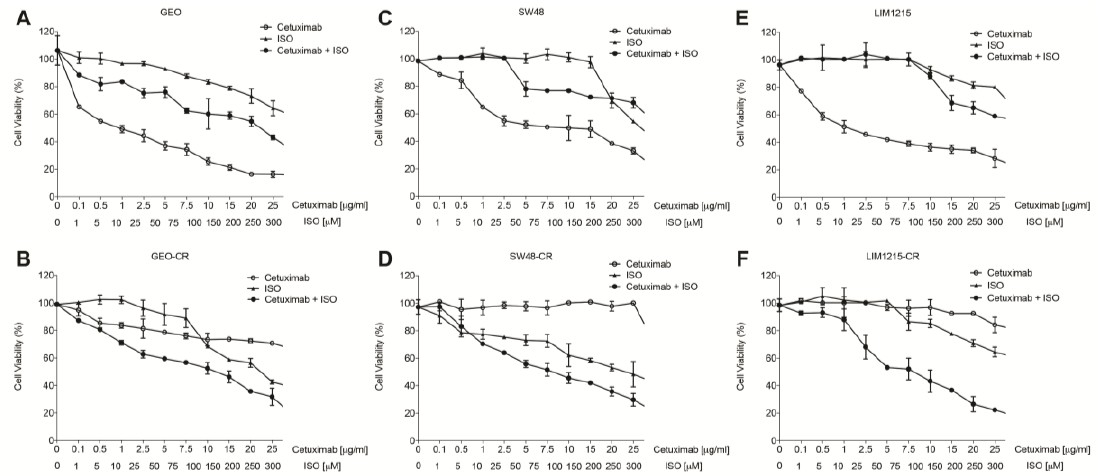
Figure 4. ( A ) MIF inhibition by the non-covalent inhibitor ISO-1 affects GEO ( A ) and GEO-CR ( B ), SW48 ( C ) and SW48-CR ( D ), LIM1215 ( E ) and LIM1215-CR ( F ) cell viability. Cell viability was evaluated by MTT staining following treatment for 72 h with cetuximab (range: 0.1 – 25 µg/mL), ISO-